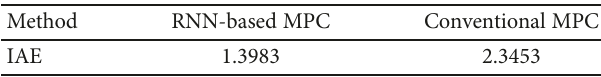
Table 4: IAEs of the proposed RNN-based MPC and conventional